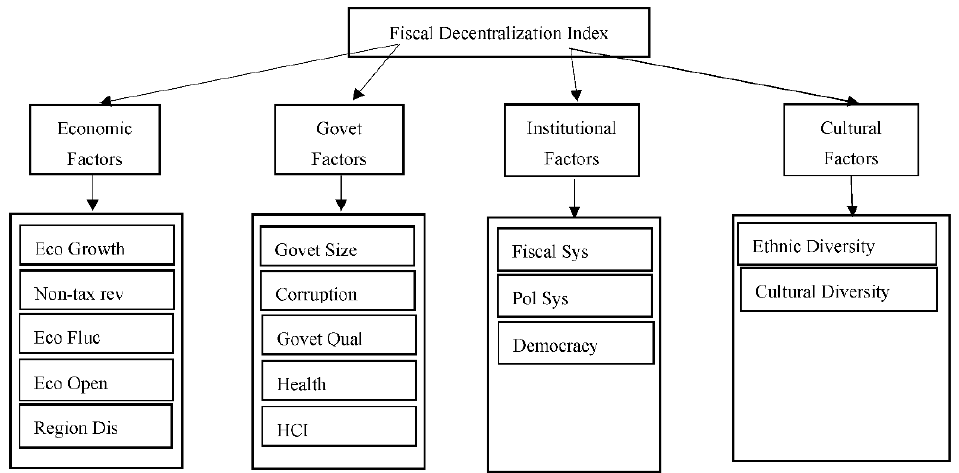
Figure 1. Fiscal decentralization index structure. Source: developed by authors.